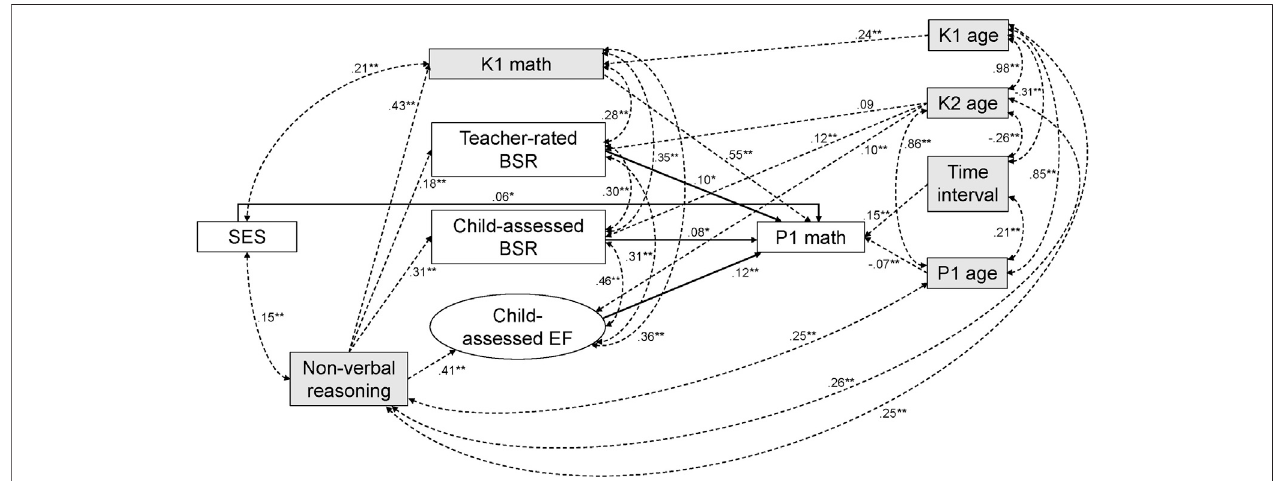
FIGURE3| Model 2examined the in fl uences ofsocio-economicstatus (SES), child-assessedexecutivefunctioning (EF), child-assessedbehavioralself-regulation (BSR), and teacher-rated BSR on math achievement at Primary 1 (P1 math), controlling for child ’ s age at Kindergarten 1 (K1), K2, and P1, time interval between K1 and P1 assessment of math skills, math skills at K1, and non-verbal reasoning. Dashed paths re fl ect predictive and correlational paths involving control variables. All path coef fi cients are standardized estimates. R 2 EF (cid:1) 0.20, p < 0.01, R 2 Teacher-rated BSR (cid:1) 0.05, p < 0.05, R 2 Child-assessed BSR (cid:1) 0.13, p < 0.01, R 2 P1 math (cid:1) 0.50, p < 0.01, * p < 0.05, ** p < 0.01.